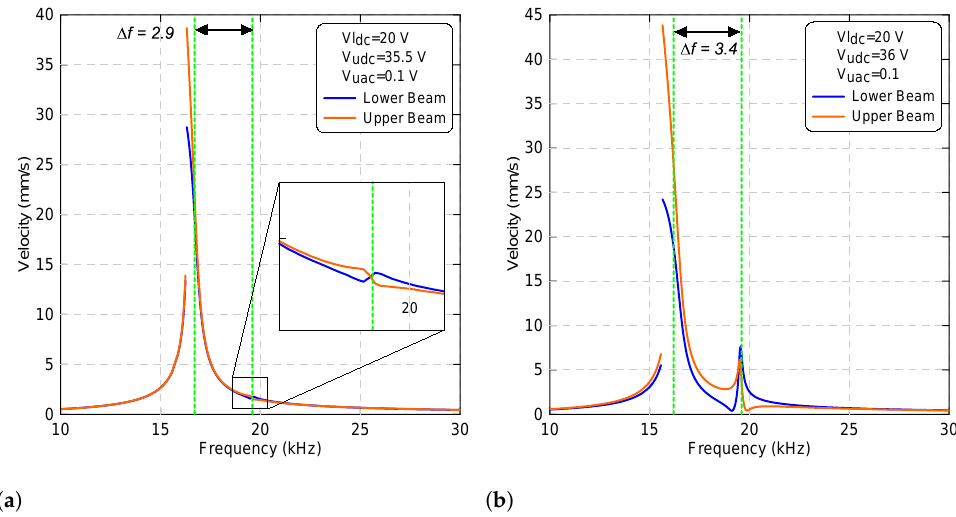
Figure 13. The frequency-response curves of the lower beam resonance frequency f l 1 and of the upper beam resonance frequency f u 1 with a lower voltage set to V ldc = 20 V and an upper voltage set to: ( a ) V udc = 35.5 V and ( b ) V udc = 36 V. The upper harmonic voltage V uac is set to 0.1 V. The lower beam results are marked with blue lines and the upper beam results are marked with orange